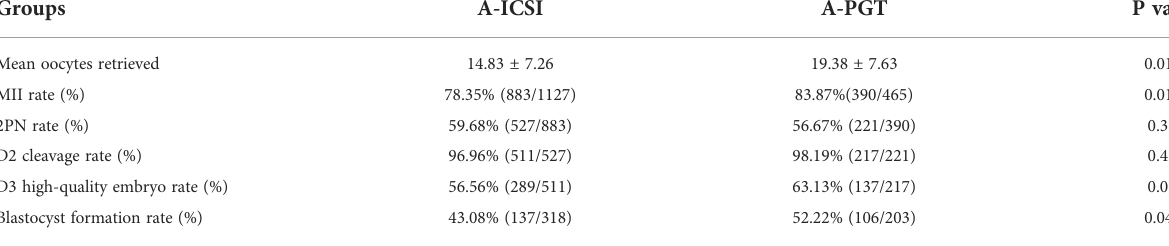
TABLE 4 Comparison of embryo development between A-ICSI and A-PGT groups.